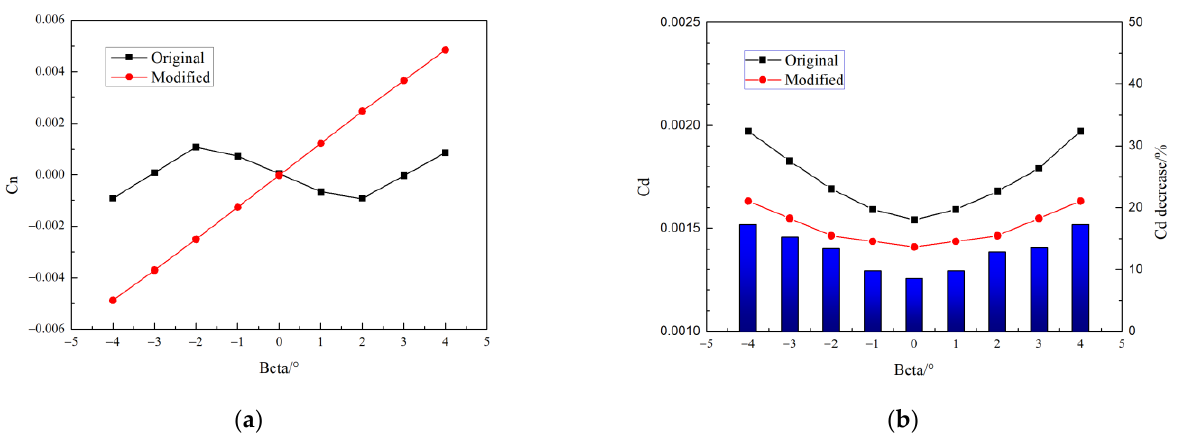
Figure 16. Coefficients of ( a ) yaw moment and ( b ) drag calculated with original (black) and modified (red) model.